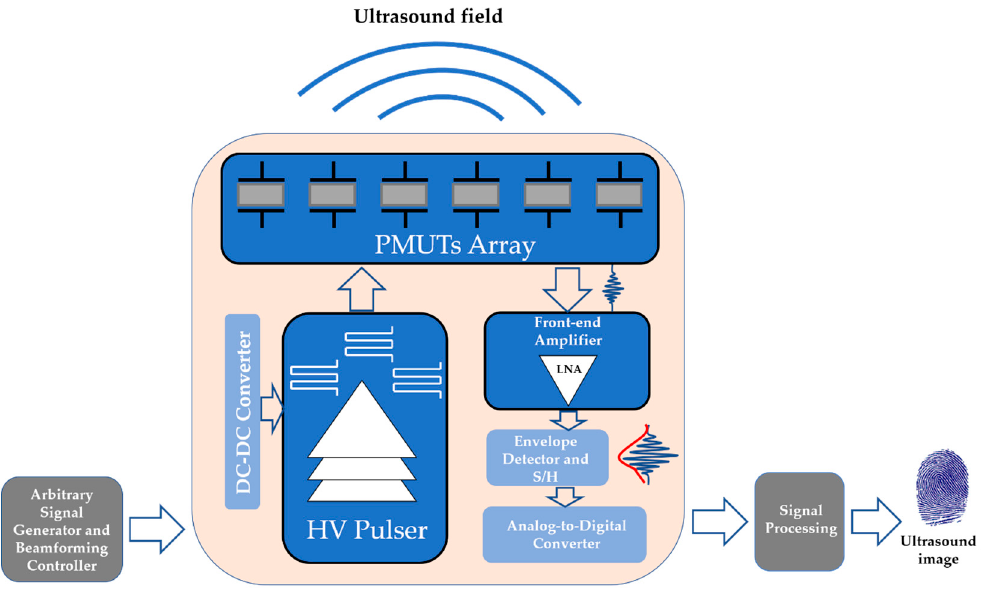
Figure 1. Image of an ultrasonic system block diagram.